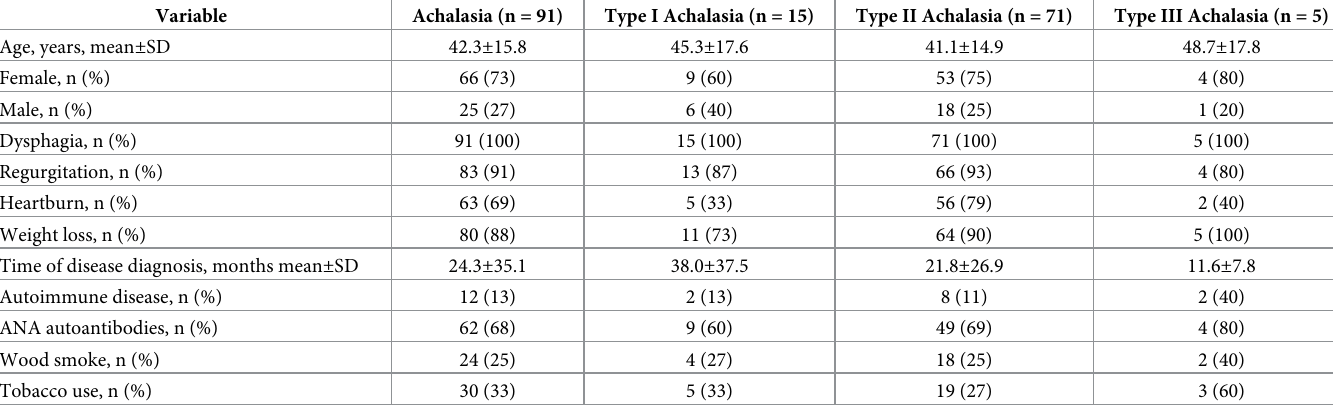
Table 1. Clinical and demographic information of Mexican patients with achalasia.